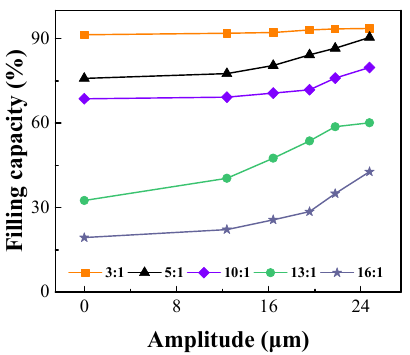
Figure 8. Effect of the ultrasonic amplitude on the filling capacity (injection pressure 7 MPa, injection speed 40 mm/s).